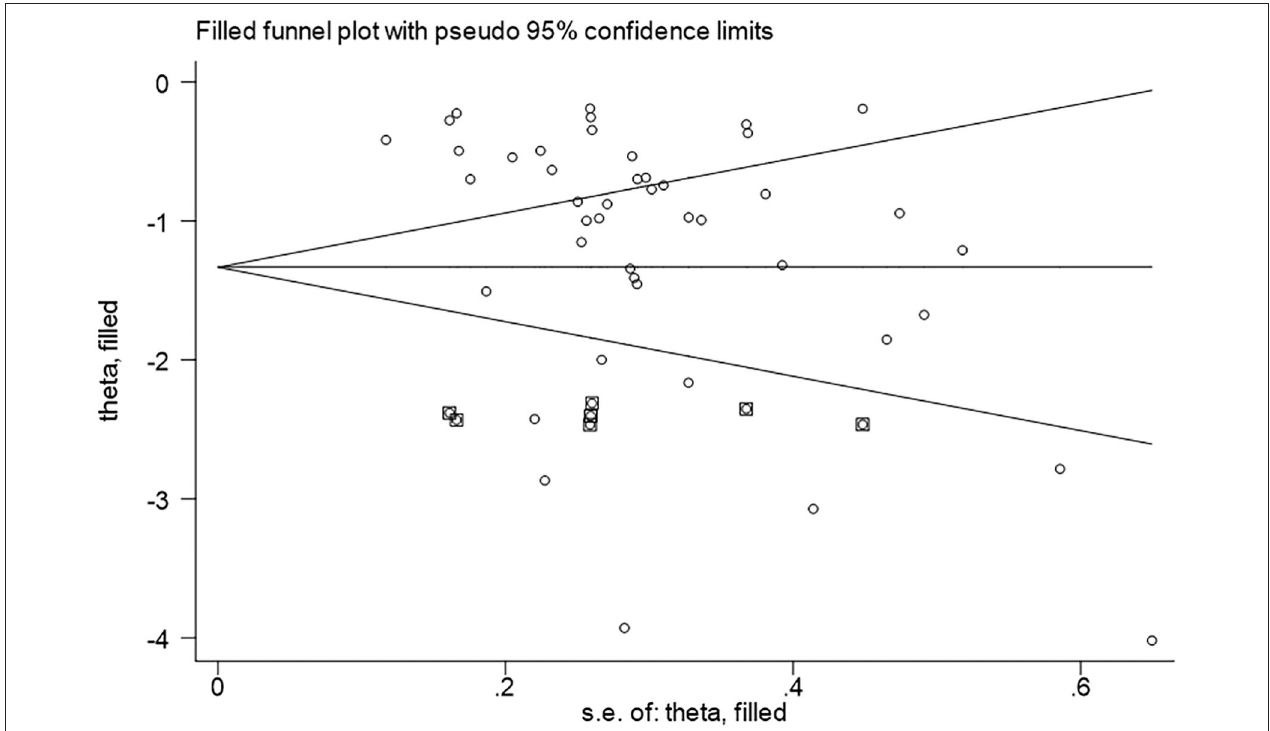
FIGURE 4 | Trim and fill method for evaluating publication bias (the circles alone are real studies and the circles enclosed in boxes are “filled” studies. The horizontal line represents the summary effect estimates, and the diagonal lines represent pseudo-95% CI limits).